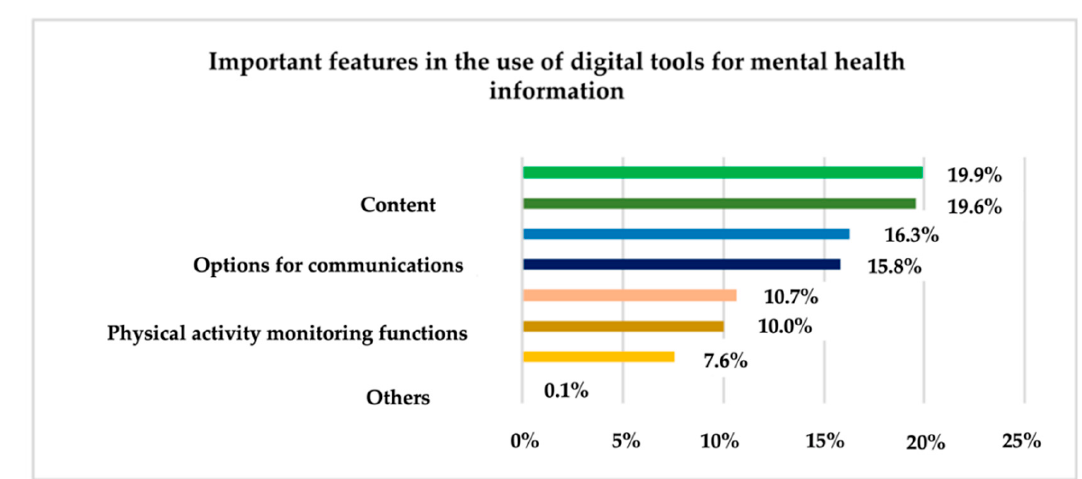
Figure 11. Features in the use of digital tools for mental health information.